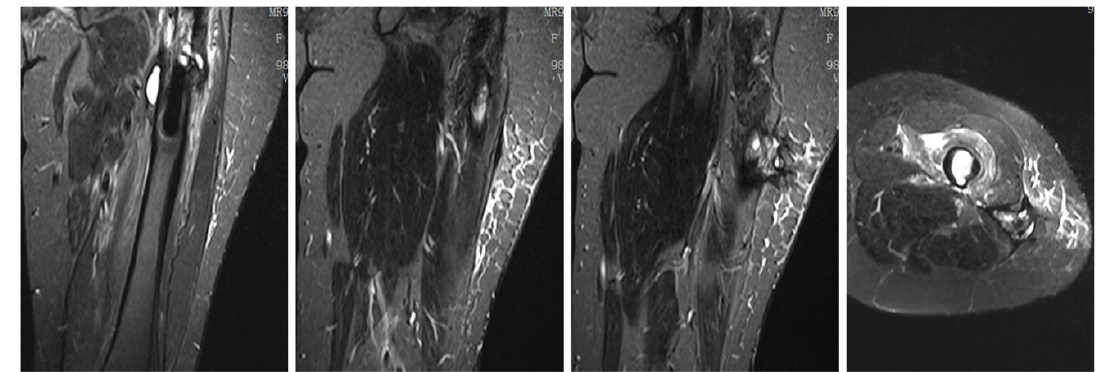
Figure 2. Coronal and horizontal plane of magnetic resonance T2-weighted images show effusion around the femur connected to subcutaneous tissue through an underlying